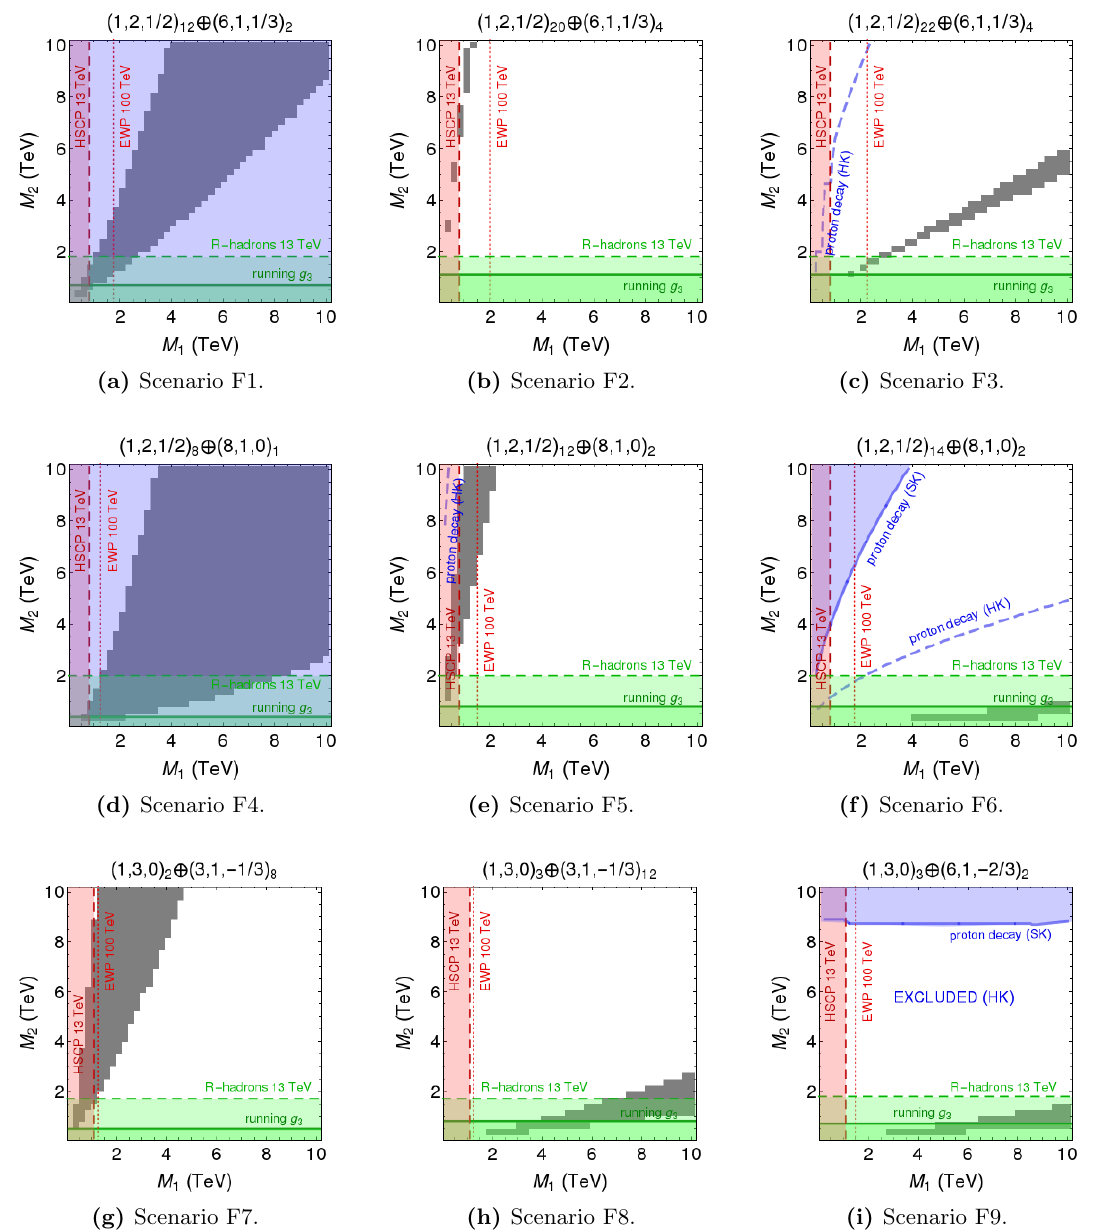
Figure 3. Summary of experimental bounds on VL masses M 1 and M 2 for scenarios F1{F9. In gray the PGU region is indicated. The area below and left to the solid green line is excluded by the measurement of the running strong coupling constant by CMS [44]. The limits from the 13 TeV ATLAS R -hadrons search [45] are indicated as a dashed green line. The corresponding lepton- like HSCP search excludes the area left to the dashed red line. 100 TeV projections for the EWP tests [46] are depicted as red dotted lines. Blue shaded region marks the exlusion by the proton decay measurement at Super-Kamiokande [42]. A projected reach of Hyper-Kamiokande [43] is shown as a blue dashed